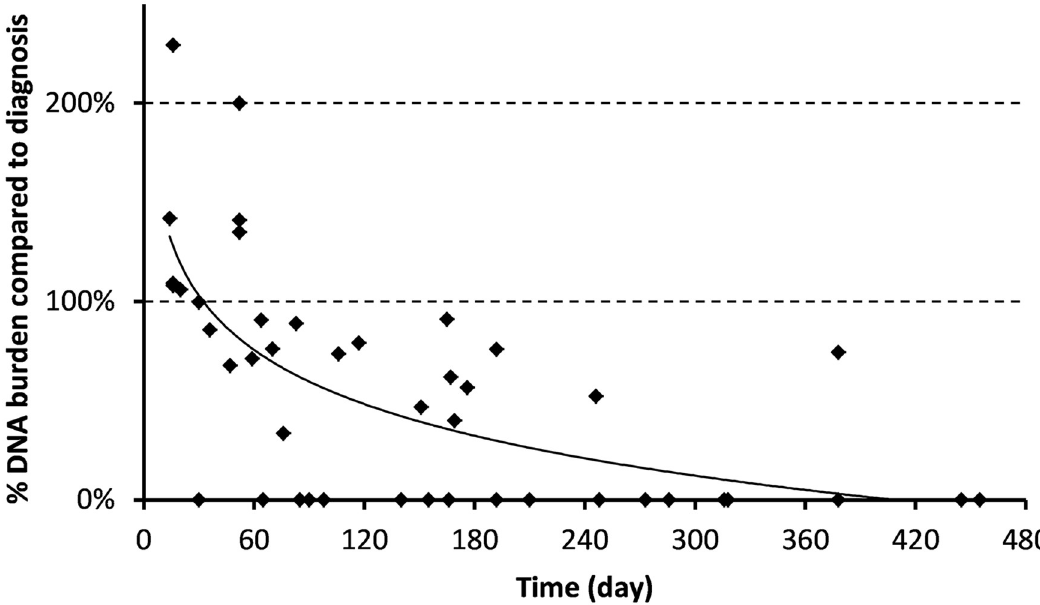
Fig 3. Relative value of serum DNA load after treatment compared to the initial load (day 0), according to the number of days post-treatment (n = 23 patients).